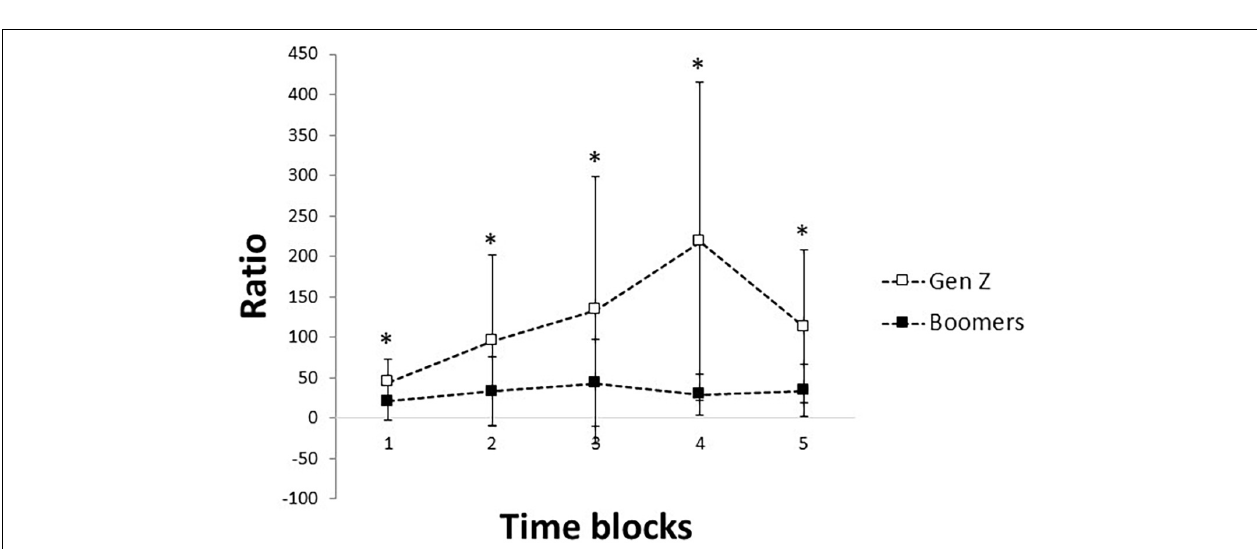
FIGURE 2 | Mean and standard deviation of the performance scores (A) and game lives (B) across the five-time blocks in the Gen Z ( N = 16) and Baby Boomer age groups ( N = 16). Asterisks denote significant interactions between the groups and time blocks ( p < 0.023).